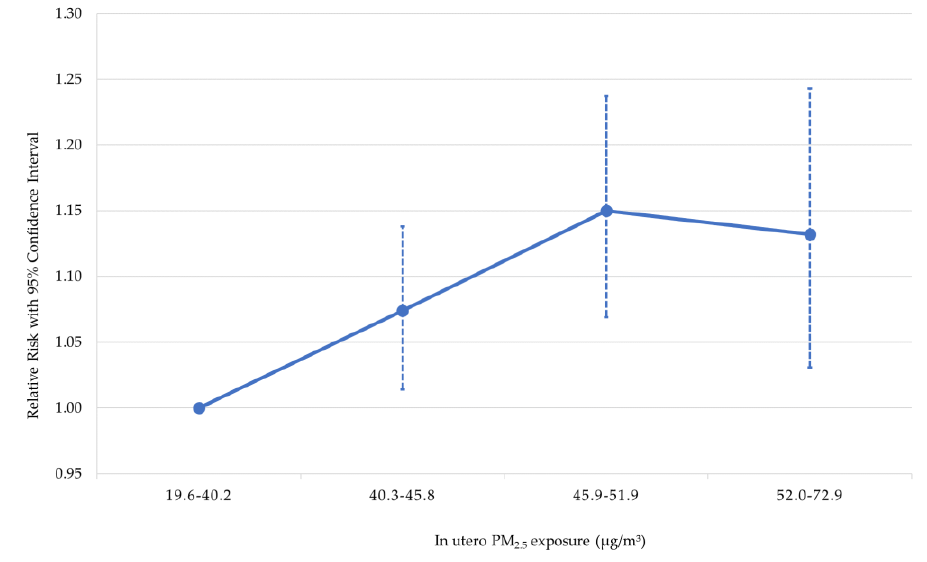
Figure 3. Adjusted relative risk for stunting by quartile of in utero PM 2.5 exposure.